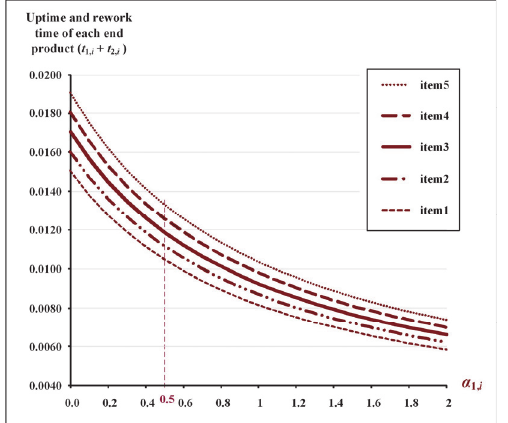
Fig. 18. The sum of each end product’s uptime and rework time ( t 1 ,i + t 2 ,i ) concerning α 1, i